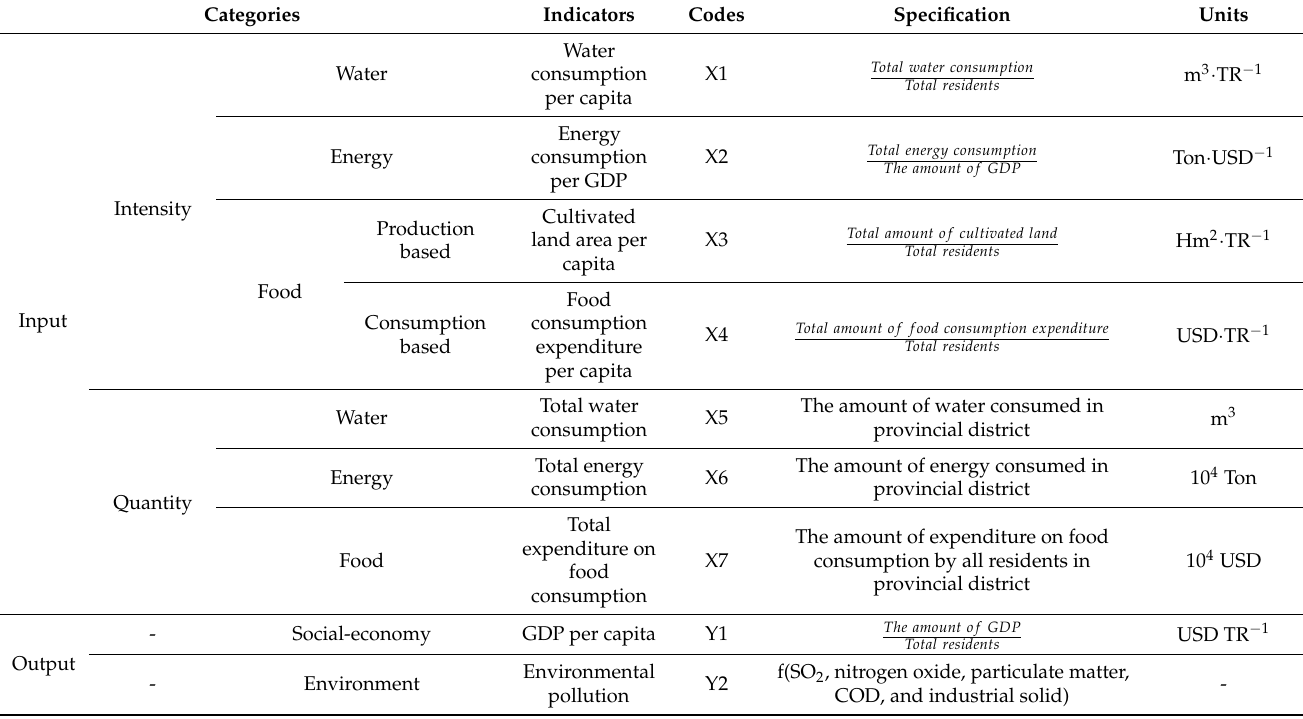
Table 1. Input–output index system of the DEA model of WEF.